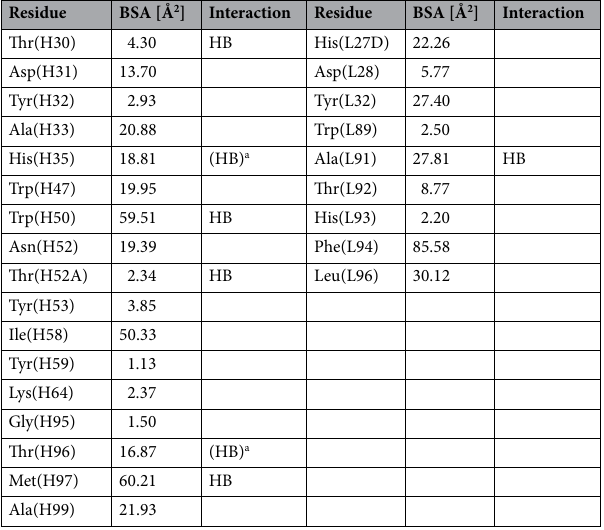
Table 2. Residues of the Fab M3/38 that form van der Waals contacts with the hGal3 peptide in the complex. Buried surface areas (BSA) > 1 Å 2 are reported for each of the contacting amino acids and hydrogen bonds (HB) are indicated. a Indirect H-bond (mediated by a water